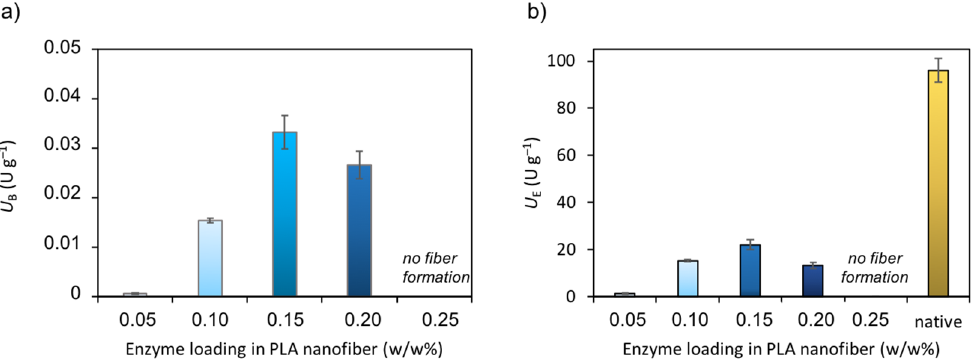
Figure 4. The effect of enzyme loading on the ( a ) specific biocatalyst activity ( U B ) and ( b ) specific enzyme activity ( U E ) of Pc PAL entrapped in PLA nanofibers in ammonia elimination from L -phenylalanine. Every measurement was made in triplicate. The difference between all samples was significant ( p < 0.005) in the case of U B and in also in the case of U E except between enzyme loading 0.10 and